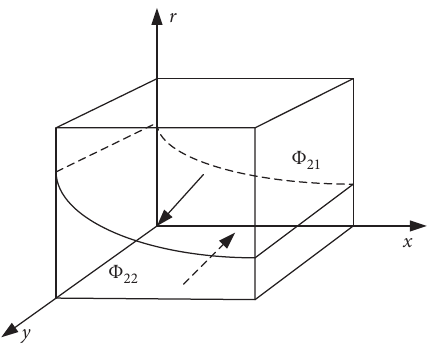
Figure 6: Dynamic evolution of ESCOs’ decisions